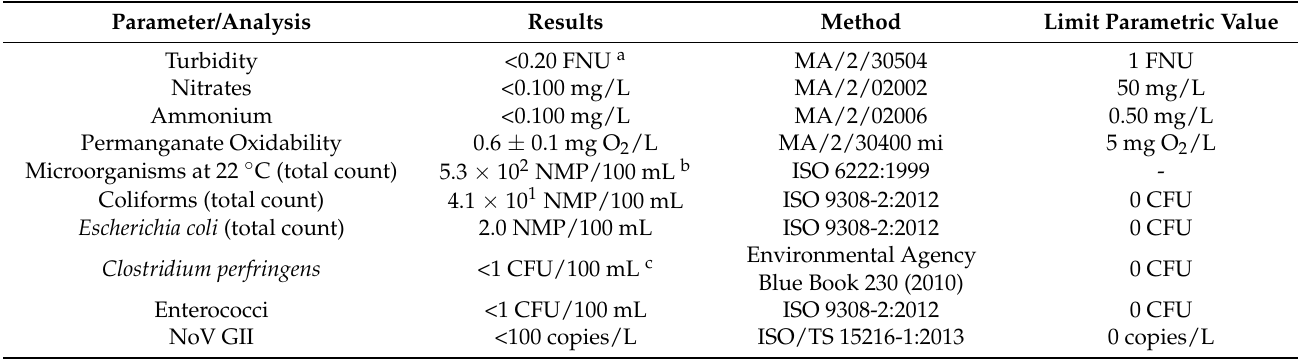
Table 2. Microbial and chemical results from the natural water font. Samples were collected during the environmental investigation (February) in response to the NoV